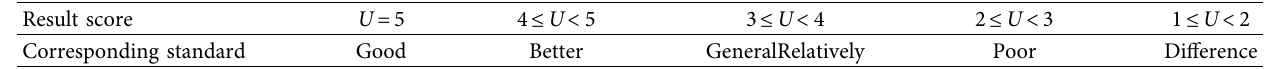
Table 3: Standard set of final evaluation results.